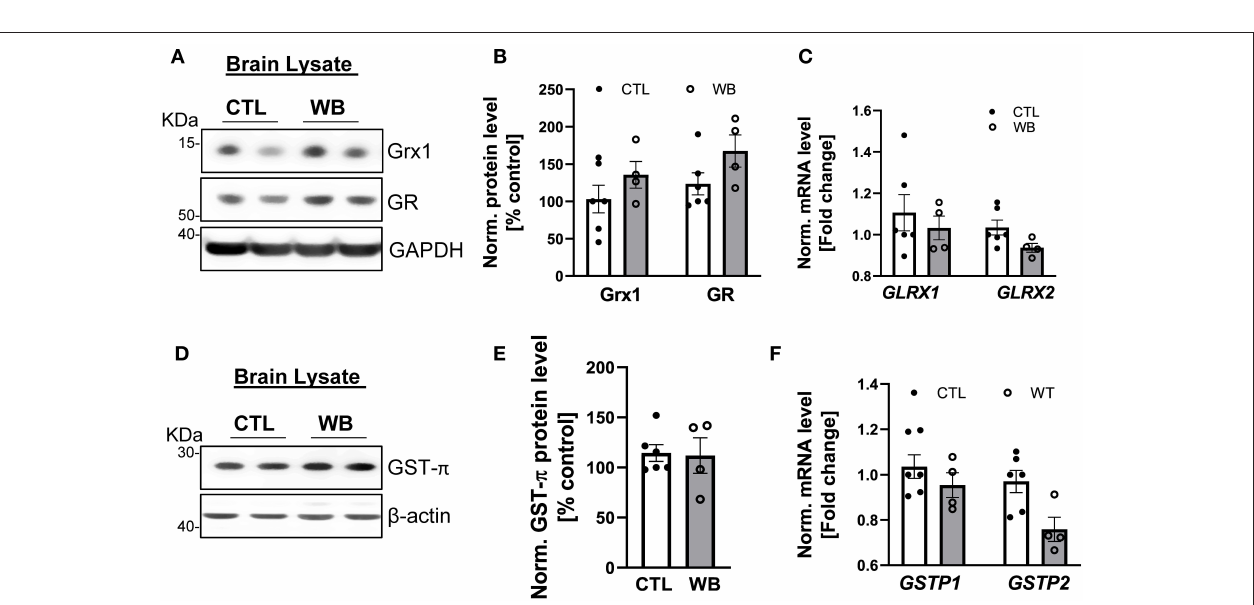
FIGURE 5 | the control group. Red boxes indicate the area shown in higher magnification. Scale bars = 100 µ m. (I) Significant increase in plasma triglycerides in ethanol-fed ApoE − / − mice (WB) compared to control (CTL) group but (J) no increase in total cholesterol plasma level. (A,D) Representative immunoblot results and